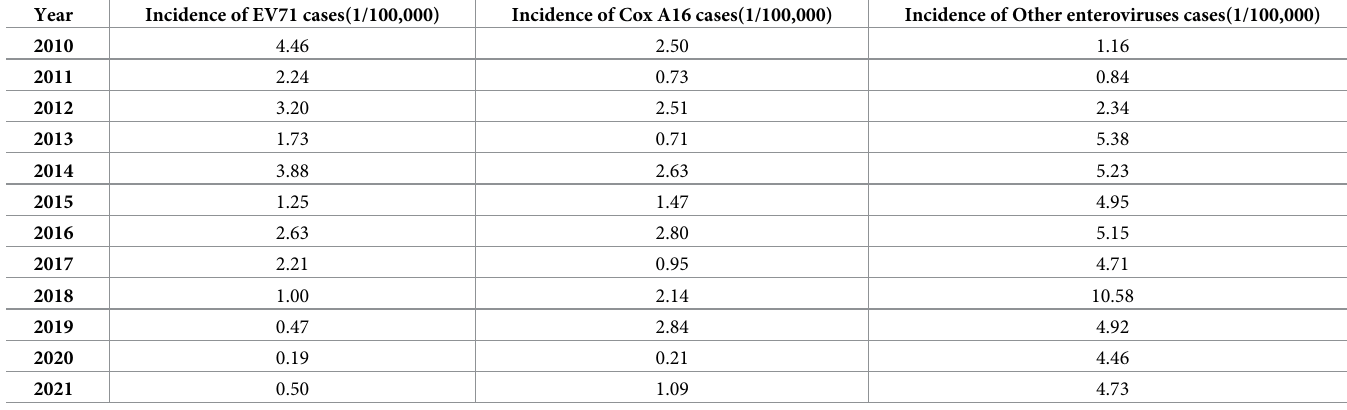
Table 1. Virological surveillance of HFMD from 2010 to